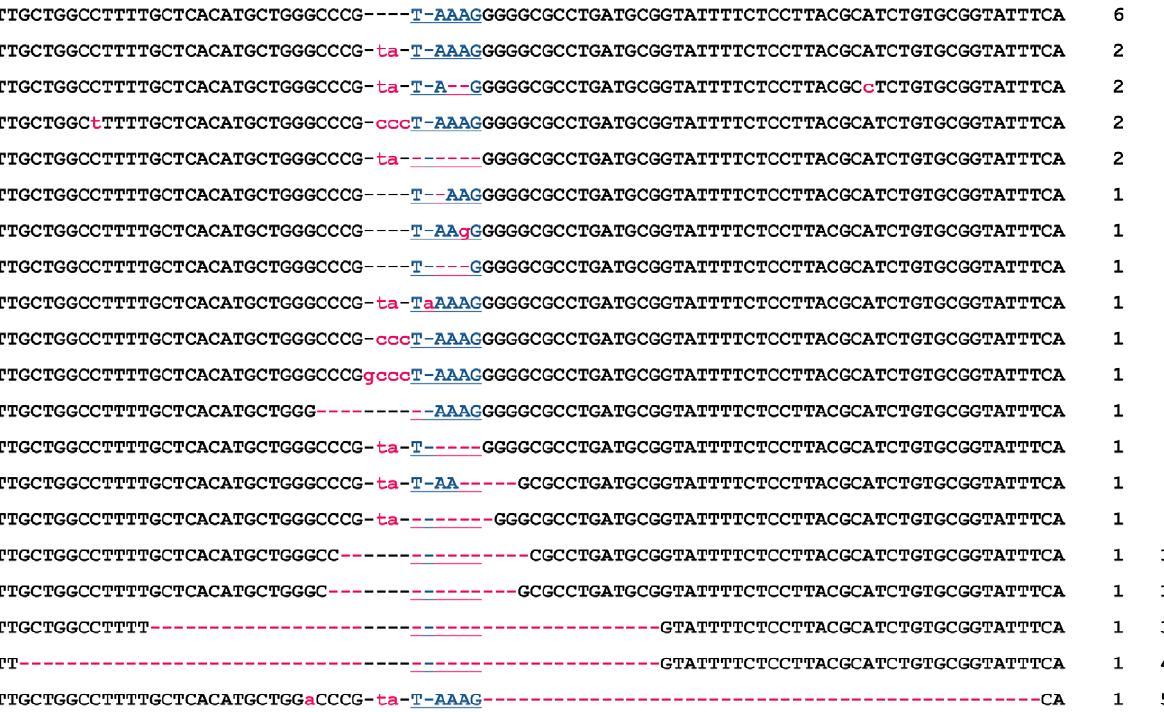
Figure 1. Transposase-mediated excision of the TcBuster transposon in HEK-293 cells. ( a ) An agarose gel of the excision PCR. Plasmid DNA was extracted from transfected HEK-293 cells and used as a template for nested PCR to detect the excision of the transposon DNA. Lane 1, 1 kb ladder; lane 2, PCR reaction without any DNA template added; lanes 3–7, PCR on extracts from cells transfected with either 1 m g of the transposon plasmid pTcBNeo (lane 3), 867 ng transposon pTcBNeo and 133 ng pCMVGFP negative control (lane 4), or 867 ng transposon pTcBNeo and 133 ng pXL-CMV-TcBuster CO transposase plasmid (three separate transfections, lanes 5–7). ( b ) The three PCR bands shown in ( a ) were gel-purified and TOPO- cloned. Clones were sequenced to determine the exact excision junction. The sequence flanking the transposon in pTcBNeo is shown at the top. The TAAAG homology region is shown in blue. Mismatches are shown in lowercase pink. Dashes are used to maintain alignment and if pink, indicate a missing bp. The sequences are ranked according to (1) incidence ( # of clones) followed by (2) number of bp not matching the highest incidence clone ( # bp mismatches).